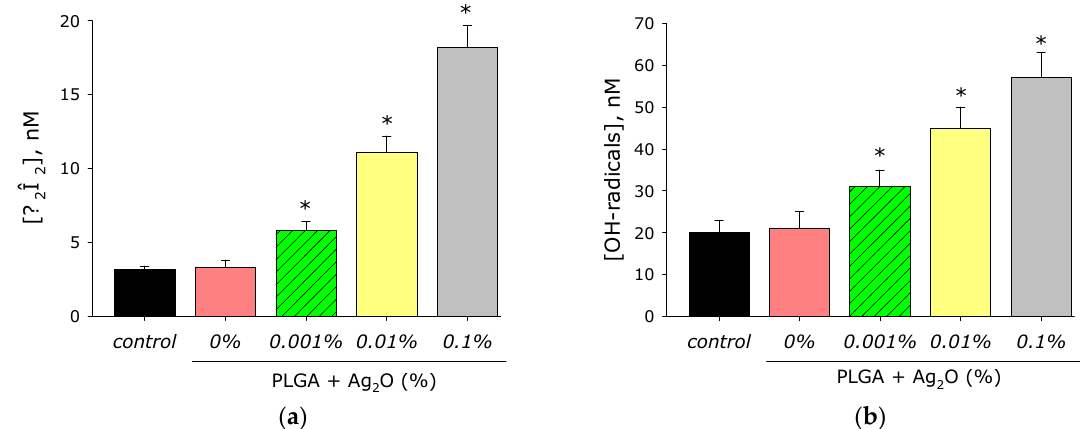
Figure 8. Effect of composite material containing PLGA and Ag 2 O nanoparticles on the generation of reactive oxygen species: ( a ) H 2 O 2 generation (2 h, 40 °C); ( b ) generation of OH-radicals (2 h, 80 °C); *— p < 0.05 versus control. Data are presented as mean ± ME.